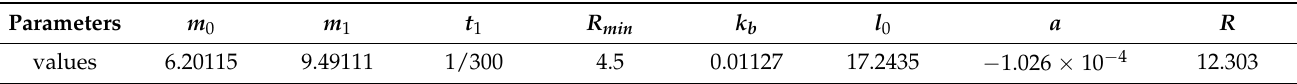
Table 1. Parameter identification.